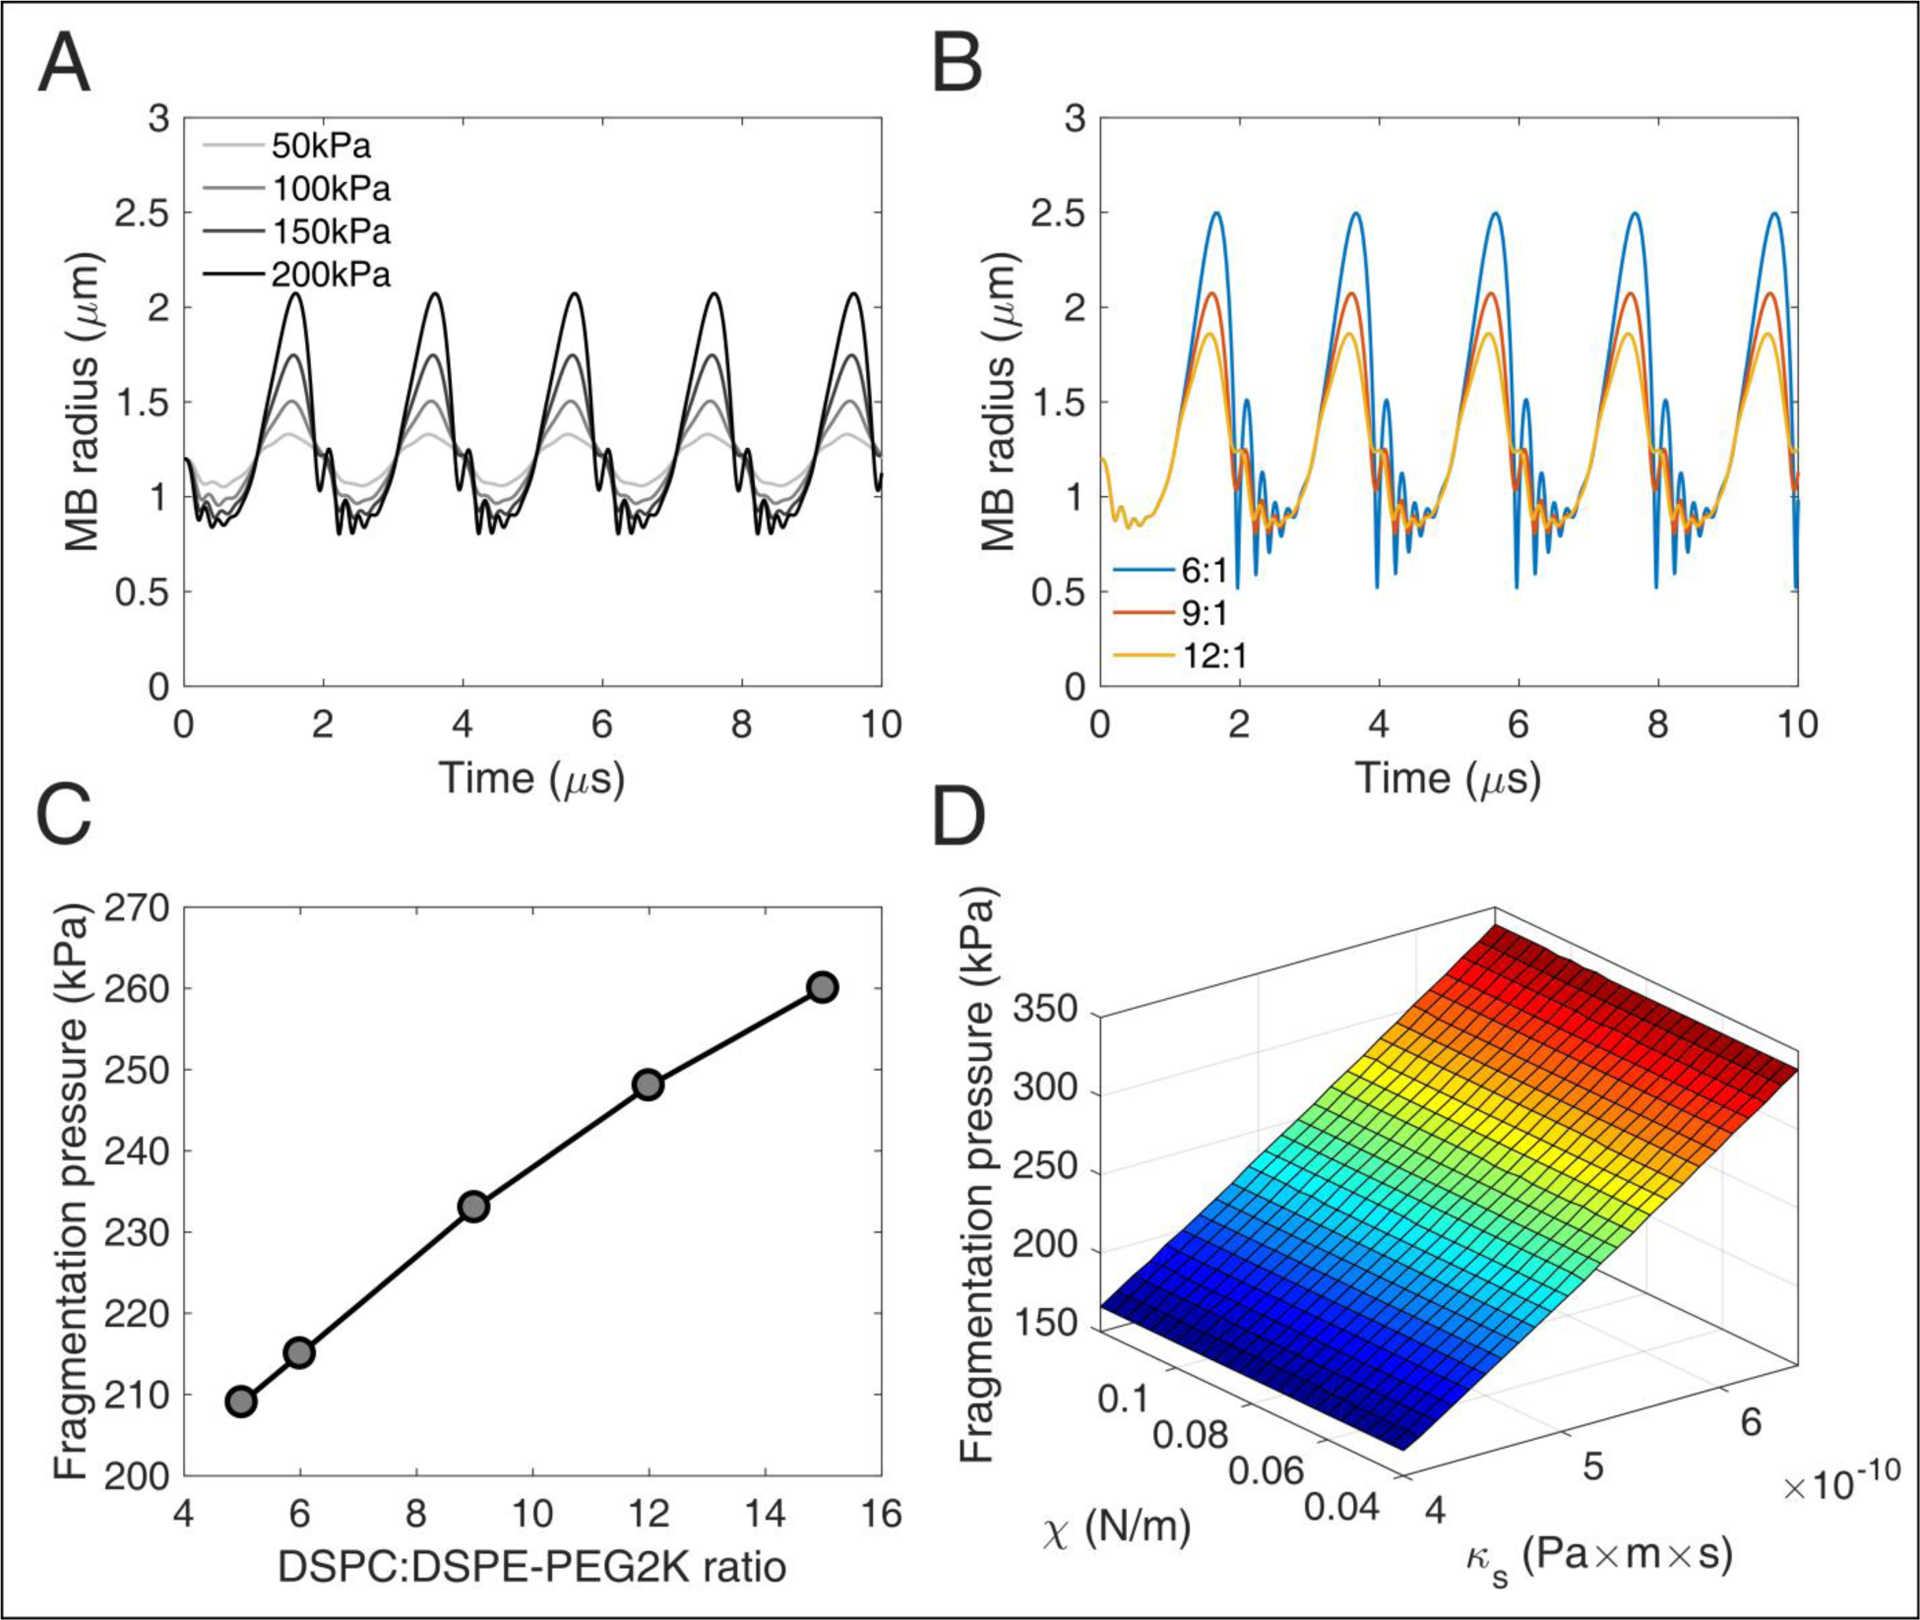
Numerical simulations of microbubble stability.(A) Radius over time for different acoustic pressures. DSPC:DSPE-PEG2K ratio: 9:1. (B) Radius over time for different DSPC:DSPE-PEG2K ratios. Peak-negative pressure: 200 kPa. (C) Fragmentation pressure across the DSPC:DSPE-PEG2K ratios. (D) Fragmentation pressure as a function of compression modulus χ and shell dilatational viscosity κS.